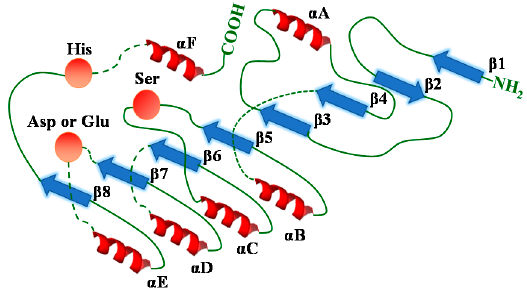
Scheme 9. Secondary structure diagram of the α / β hydrolase fold and the location of catalytic triad amino acid residues in lipases. Ser: serine residue; Asp or Glu: aspartic or glutamic acid residue;